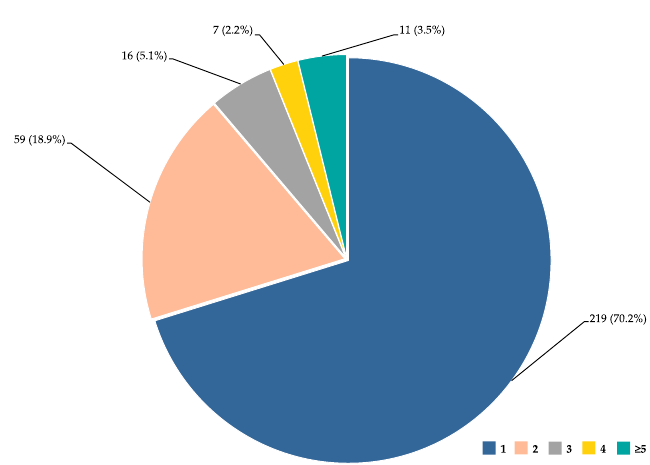
Figure 1. Gene distribution per phenotype annotations. Pie diagram shows the distribution of genes ( n (%), for a total of 312 genes) based on the number of assigned phenotypic terms (1, 2, 3, 4, and ≥5).